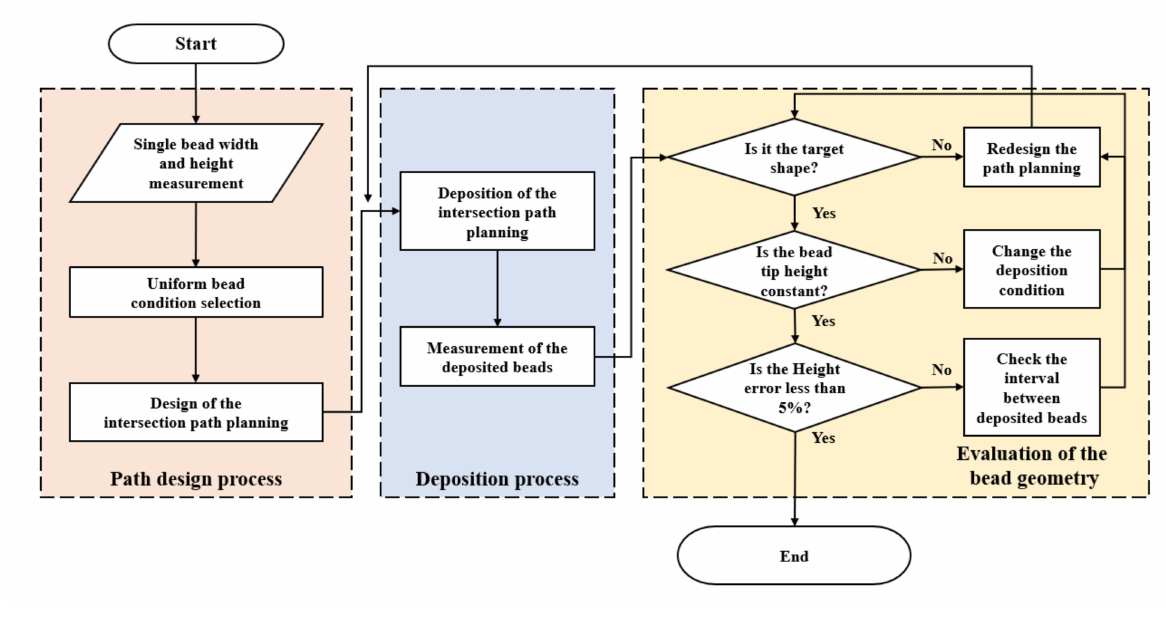
Figure 9. Flowchart of multi-layer intersection deposition in WAAM.